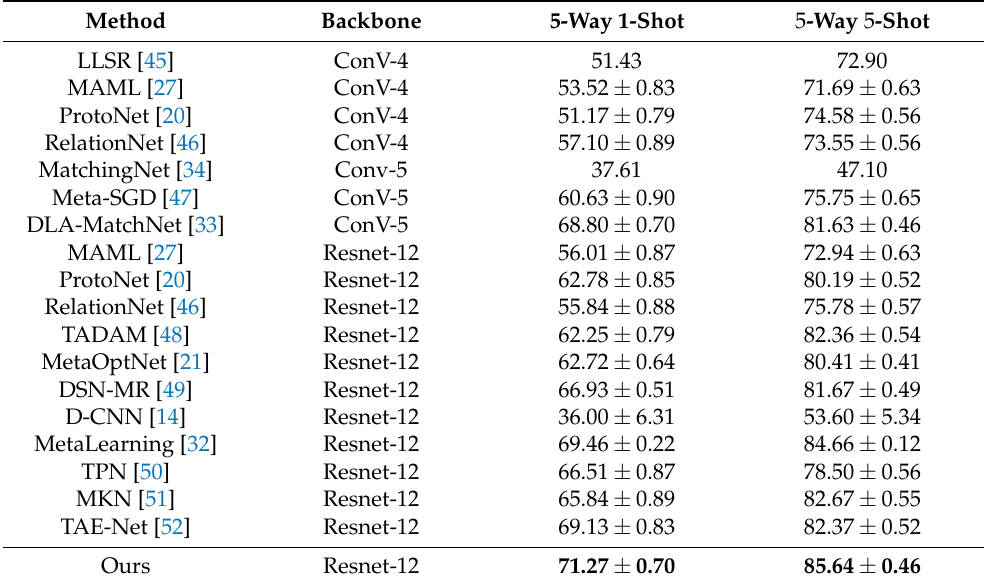
Table 2. The few-shot classification accuracies on the NWPU-RESISC45 with 95% confidence intervals over 600